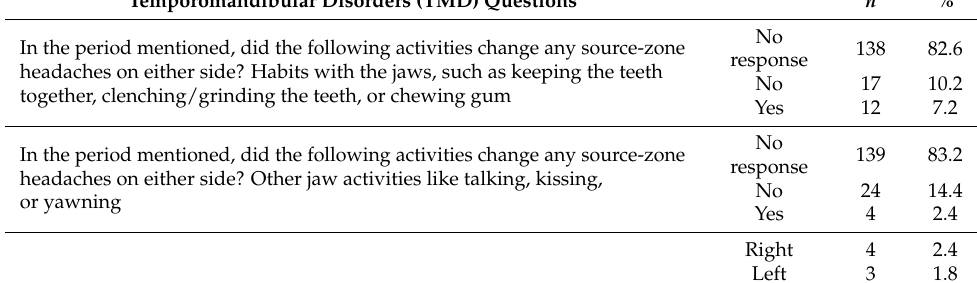
Table 2. Cont. Temporomandibular Disorders (TMD) Questions n